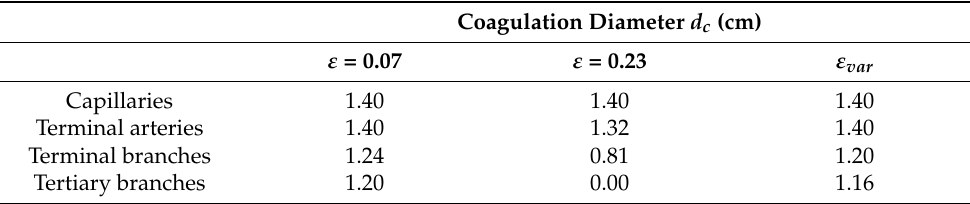
Table 5. Coagulation diameters obtained for the different porosity models.